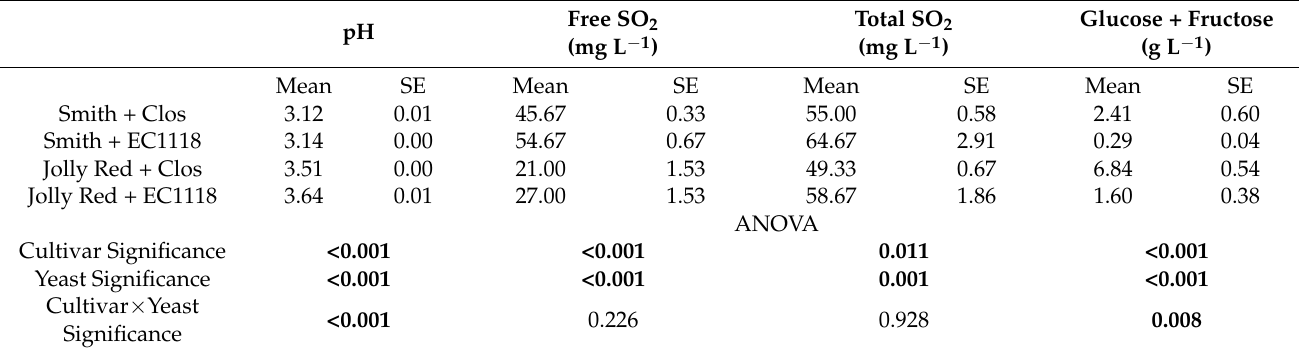
Table 2. Wine characterization (average values ± standard errors) at the end of the pomegranate winemaking process (3 months after end of fermentation). The significance of the cultivar, yeast, and cultivar × yeast interaction effects are also reported ( p -values